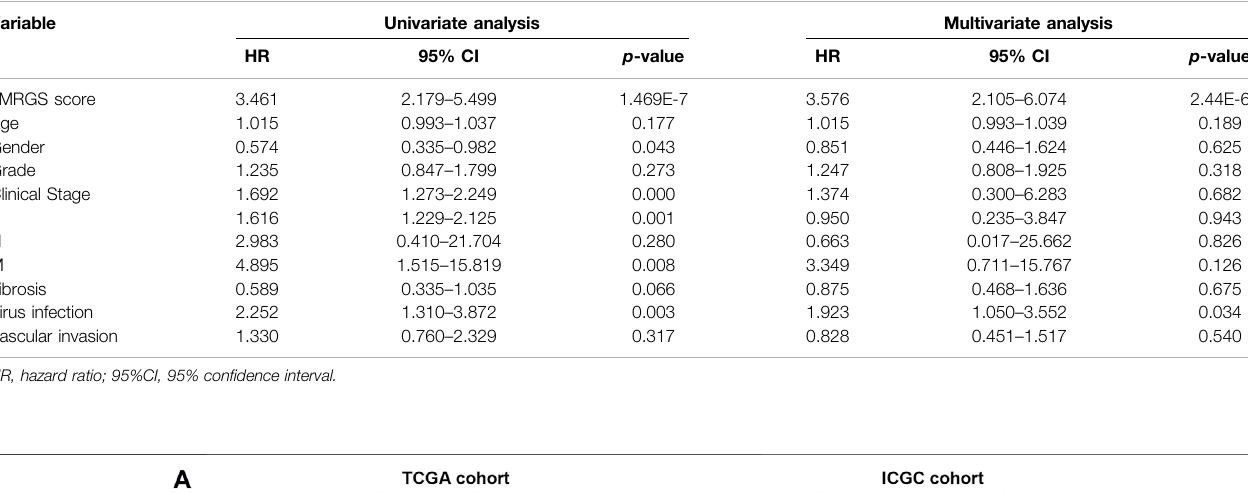
Frontiers in Cell and Developmental Biology |